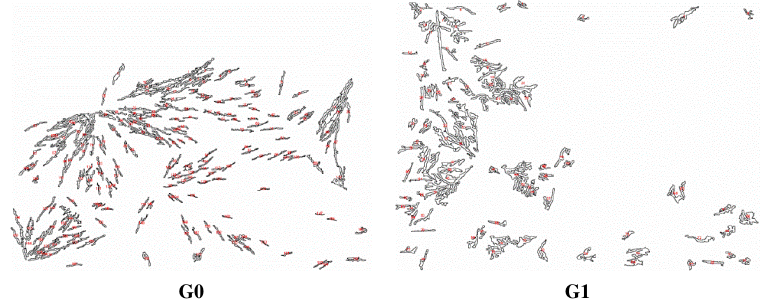
Fig. 8. Line segments in the images for grades 0 and 1.